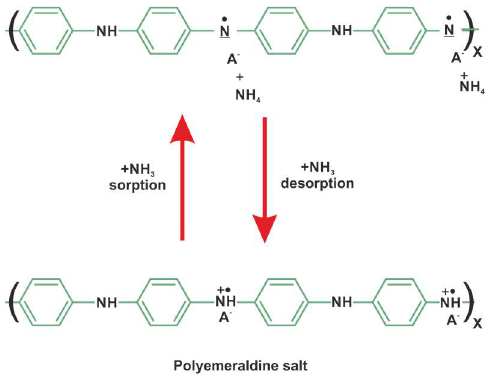
Figure 12. The reaction of PANI endowed with HA mineral acids (A=Cl, HSO 4 , ClO 4 , etc.) to ammonia [26].